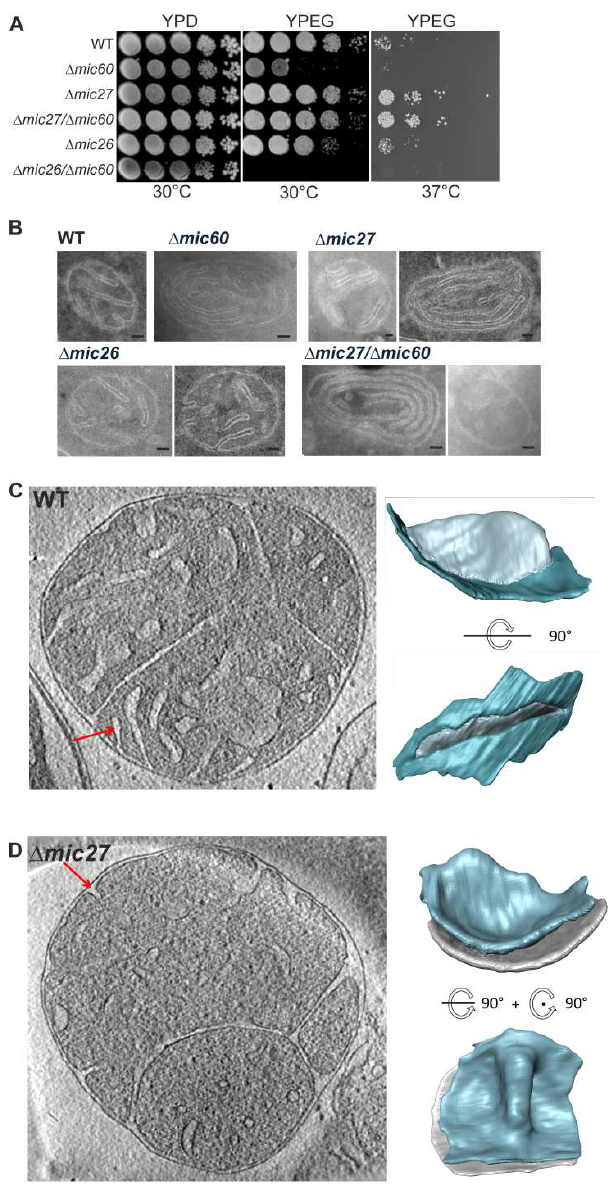
FIGURE 1: Mic27 interacts genetically with Mic60 and deletion of Mic27 leads to altered cristae morphology. (A) Growth of WT, Δ mic26 , Δ mic27 , Δ mic60 , Δ mic27 /Δ mic60 , and Δ mic26 /Δ mic60 strains were examined by serial dilutions on YPD (30°C) and YPEG medium (30 °C and 37°C). (B) Indicated strains were cultivated in YPEG, whole cells were chemically fixed and cryo-sectioned, and mitochondrial ultrastructure was determined by standard trans- mission electron microscopy. Size bars represent 100 nm. (C,D) Cryo-electron tomography of isolated wild type (C) and Δ mic27 (D) mitochondria. Left: slice from a tomogram. Right: surface ren- dered representation of a crista indicated by red arrow in tomo- graphic